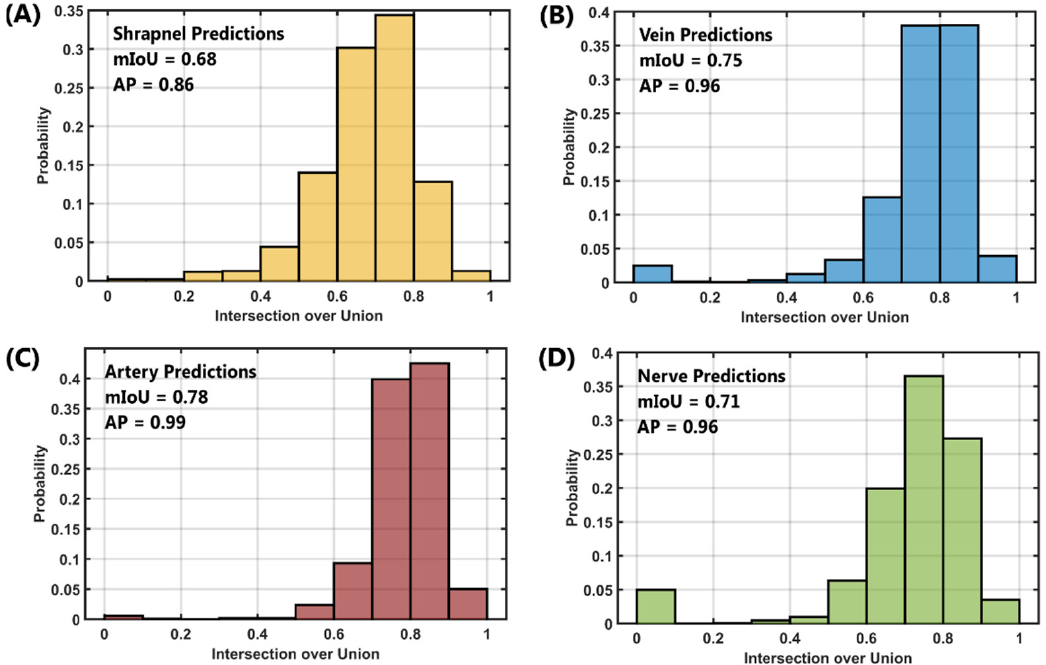
Figure 6. Intersection over Union Scores for ShrapOD with the Neurovascular Phantom. Probability distribution plots for IoU across each test data set are shown for ( A ) shrapnel, ( B ) vein, ( C ) artery, and ( D ) nerve. Mean IoU and average precision scores are shown for each prediction category. Table 1. Summary statistics for the multi-object ShrapOD. Percent true positive (TP), false positive (FP), false negative (FN), mIoU, precision, recall, F1 scores, and average precision (AP) for all object types (shrapnel, vein, artery, nerve) and then averaged across all object types. TP, FP, and FN were calculated using a minimum IoU score 0.5 for accurate predictions.